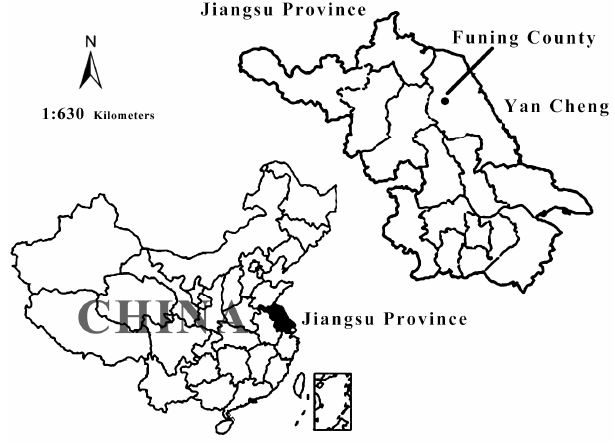
Figure 1. Location of the survey area in China. Note: This is merely a schematic diagram and does not cover the issue of territorial